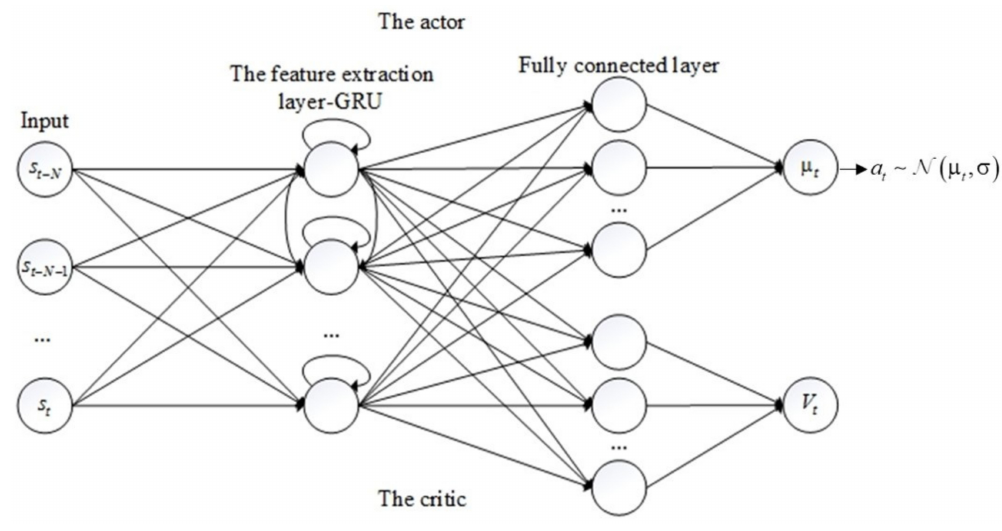
Figure 2. The architecture of the actor-critic